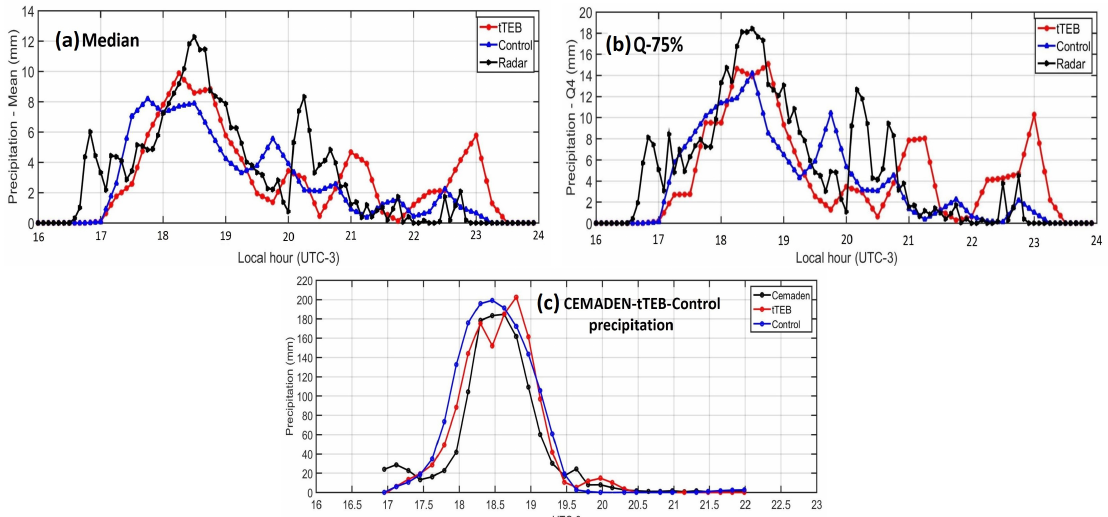
Figure 7. ( a ) Time series of mean precipitation (mm) for the region showed in Figure 6a, obtained from the control and tTEB experiments and estimated by radar. ( b ) Time series of the 75% quantile precipitation (mm) for the region showed in Figure 6a obtained from the control and tTEB experiments and estimated from the radar data. ( c ) Time series of accumulated precipitation (mm) obtained from the control and tTEB experiments and measured by the pluviometric stations shown in Figure 6b.